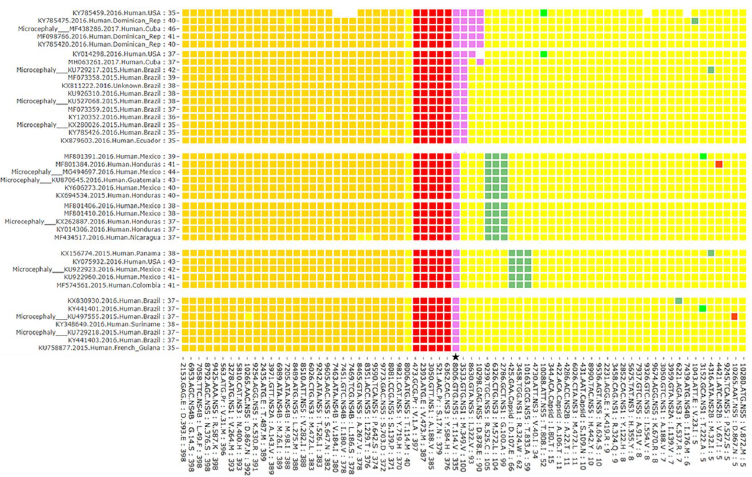
Fig 3. Overview of dispersal patterns of nonsynonymous mutations within sequences from Cluster 1. Subsections of the graph from Fig 1 showing higher resolution of mutation patterns. Cluster 1 is defined by NS5 mutation Thr/ Met114Val (Fig 4E) first detected in 2014 (marked by a star). Fragments of clusters 1.1–1.4 with genomes listed in the y axis are selected to show the locations of sequences from microcephaly cases.